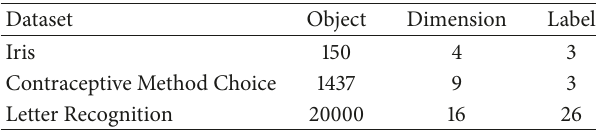
Table 3: Overview of the UCI datasets used in experiments.